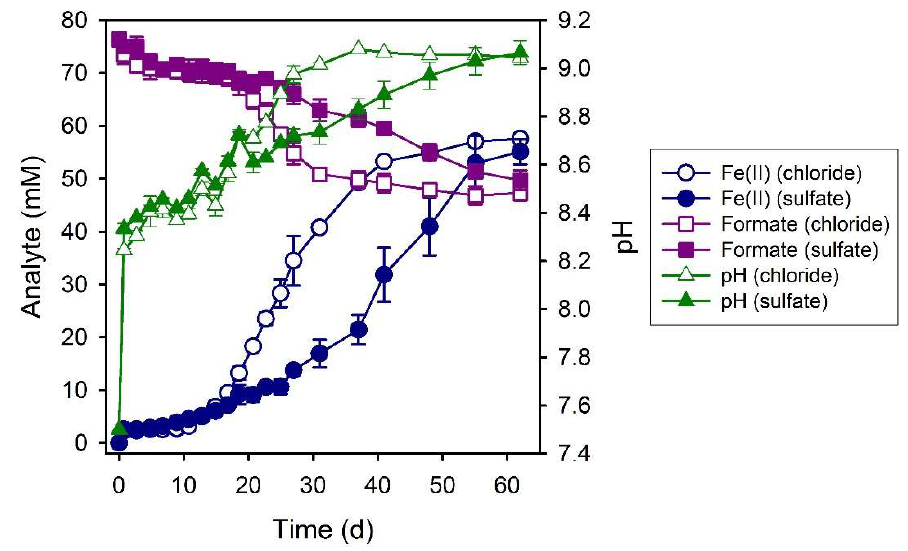
Figure 5. Fe(II) production, formate consumption, and pH during the bioreduction of lepidocrocite by S. putrefaciens CN32 with formate as the electron donor. Minerals 2019 , 9 , x FOR PEER REVIEW